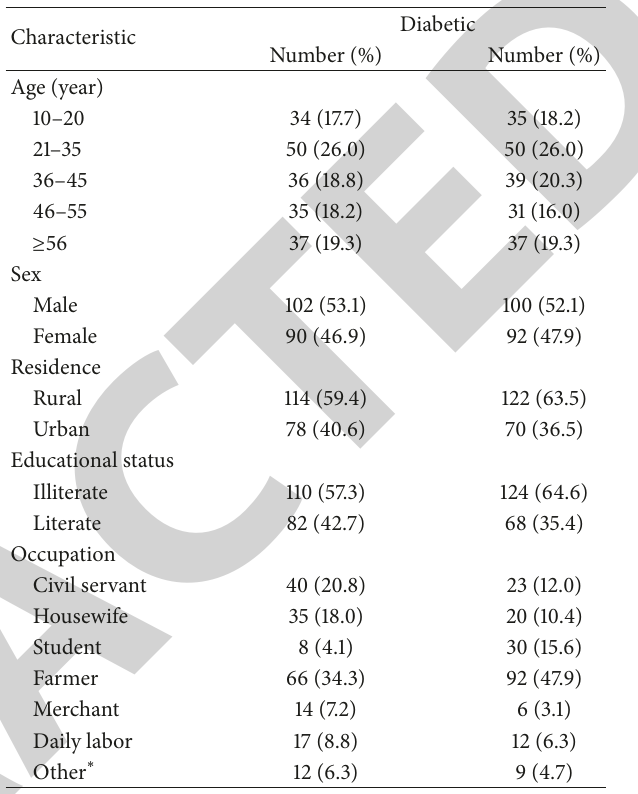
Table 1: Sociodemographic characteristics of diabetic and nondia- betic patients attending Debre Tabor Hospital, Northwest Ethiopia,